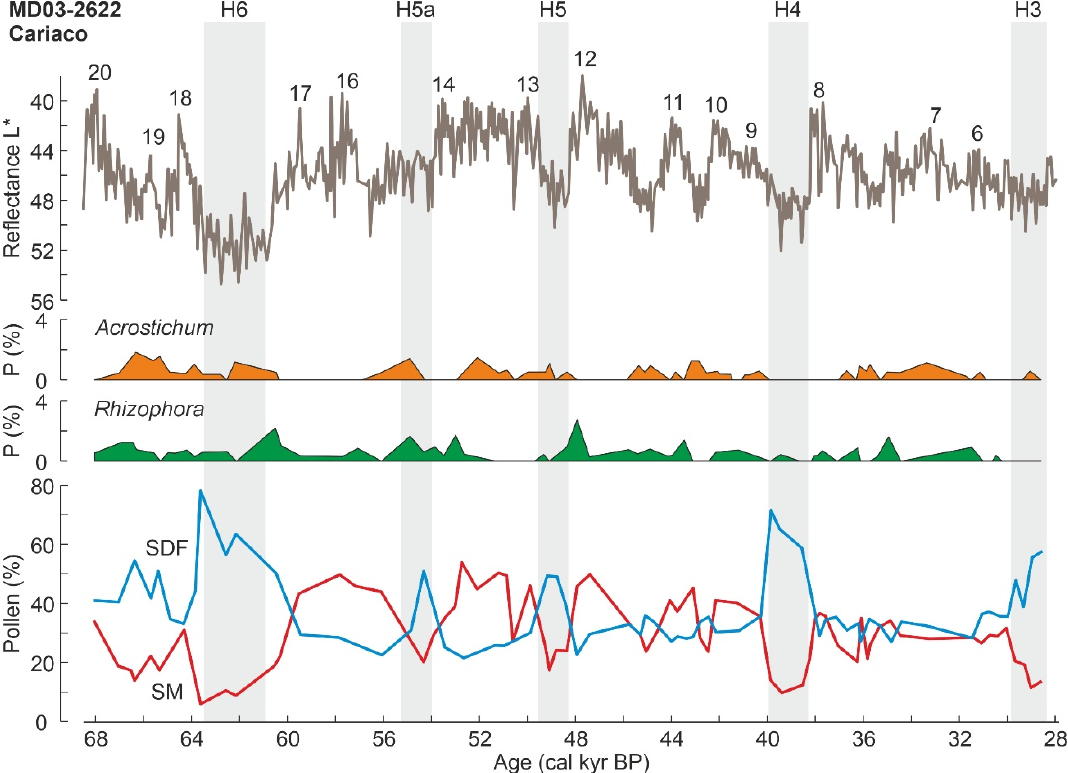
Figure 13. Cariaco pollen record from core MD03-2622 showing the changes in the abundance of mangrove elements ( Rhizophora and Acrostichum ), using the gray scale (reflectance) and the SDF (semi-deciduous forest) and the SM (salt marsh) percentage curves as a reference. H6 to H3 are Heinrich events, and numbers in the gray scale are D-O events. Composed from Refs. [187,188].